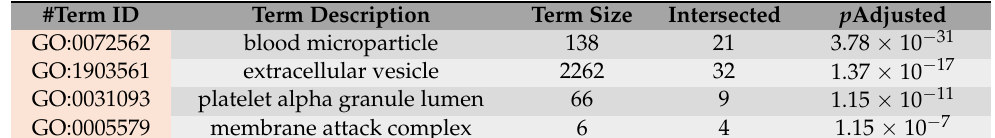
Table 2. GO Cell Component analysis of proteins enriched using GAG vs. preparations obtained with the rest of techniques. Red color denotes enrichment in GAG preparations.